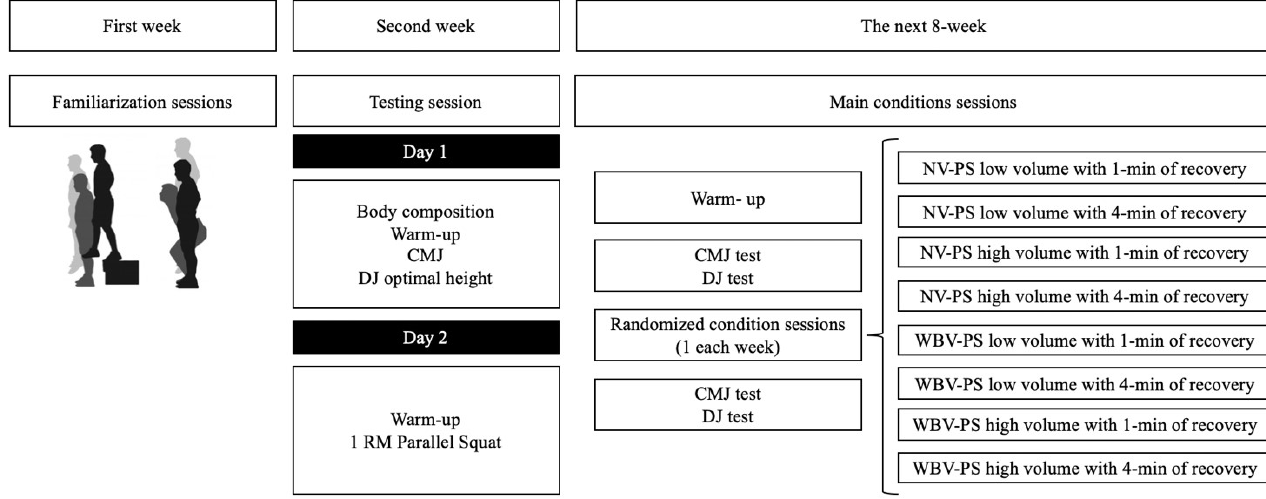
FIGURE 1. Schematic representation of the study design. 1RM, one maximal repetition; PS, parallel squat; CMJ, countermovement jump; DJ, drop jump; NV-PS, parallel squat without vibration; WBV-PS, parallel squat onto a whole-body vibration